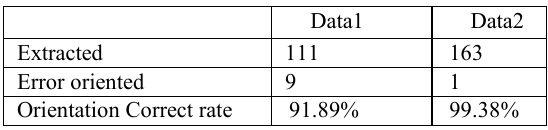
Tab. 2. Performance for the data